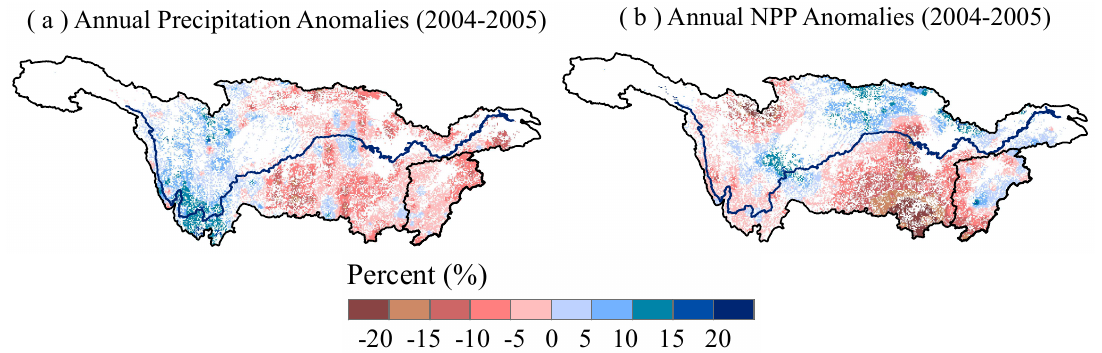
Figure 9. Comparison of the annual mean forest NPP and precipitation anomalies for the extreme drought event (compared to 1982–2013) in the Yangtze River basin during the period 2004–2005.